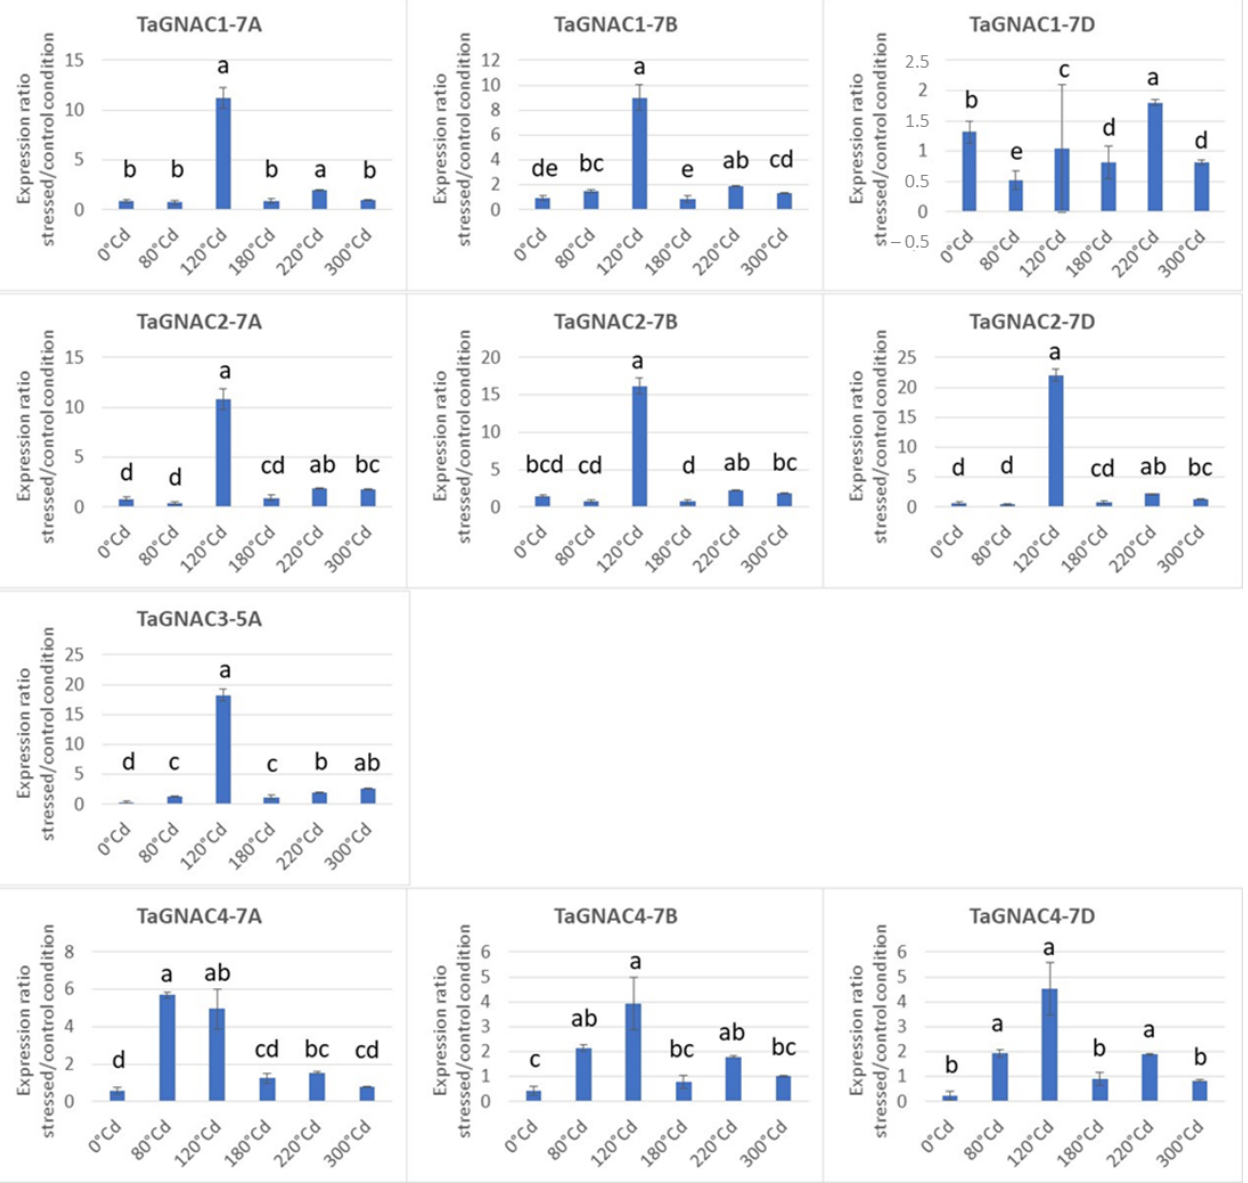
Figure 6. Ratio of the three homeologs of TaGNAC1 , TaGNAC2 , TaGNAC3 and TaGNAC4 expression in response to moderate heat stress vs. their expression in control condition. Statistical test = Kruskal Wallis, p < 0.05. The same letter means there is no significant difference.